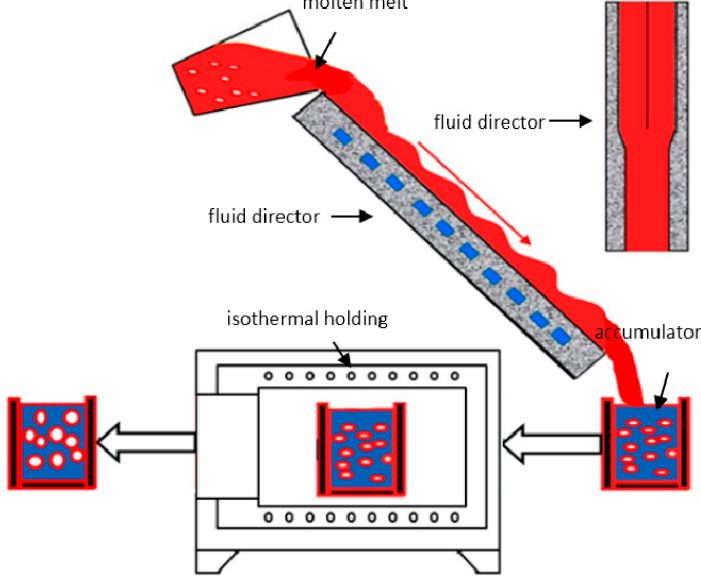
Figure 1. Schematic diagram of slurry preparation by SIM (Self-inoculation